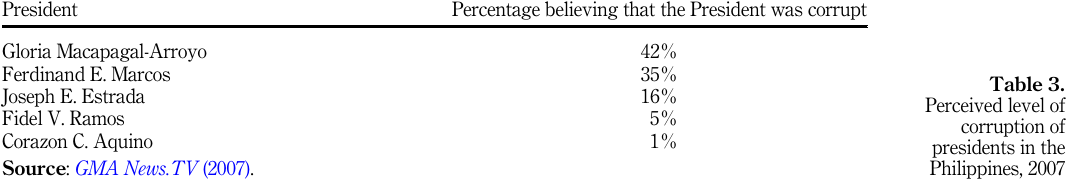
Table 3. Perceived level